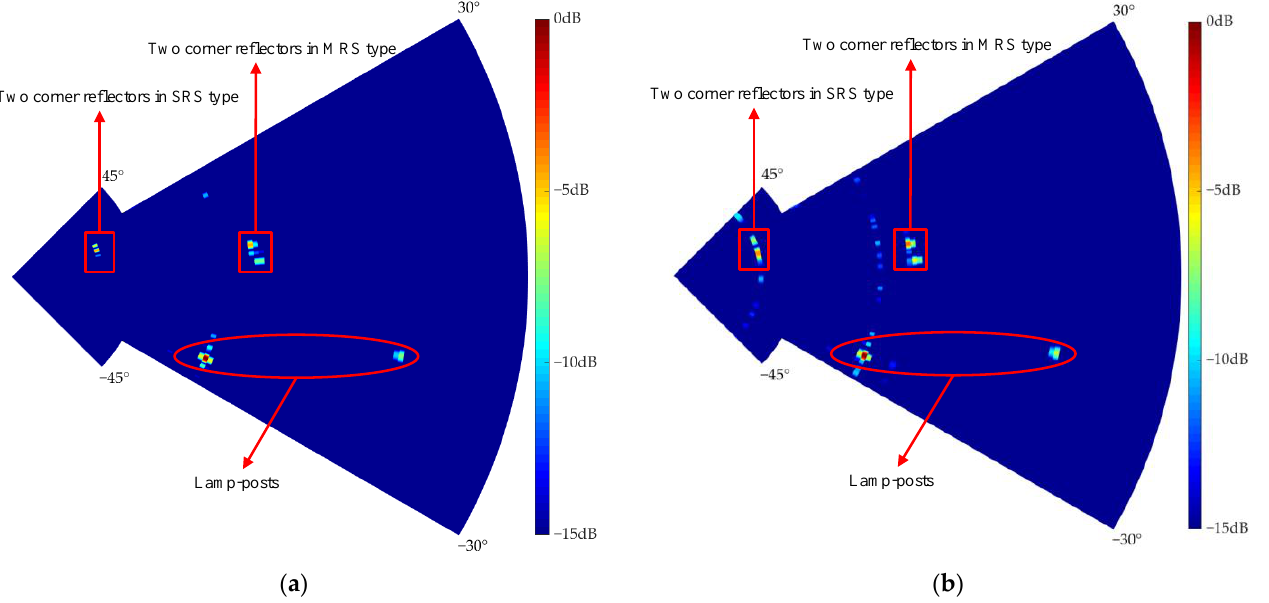
Figure 16. The measured range – azimuth spectrum estimation results with real data: ( a ) The MAM- MIMO sparse array for CARs; ( b ) the uniform half-wavelength array.